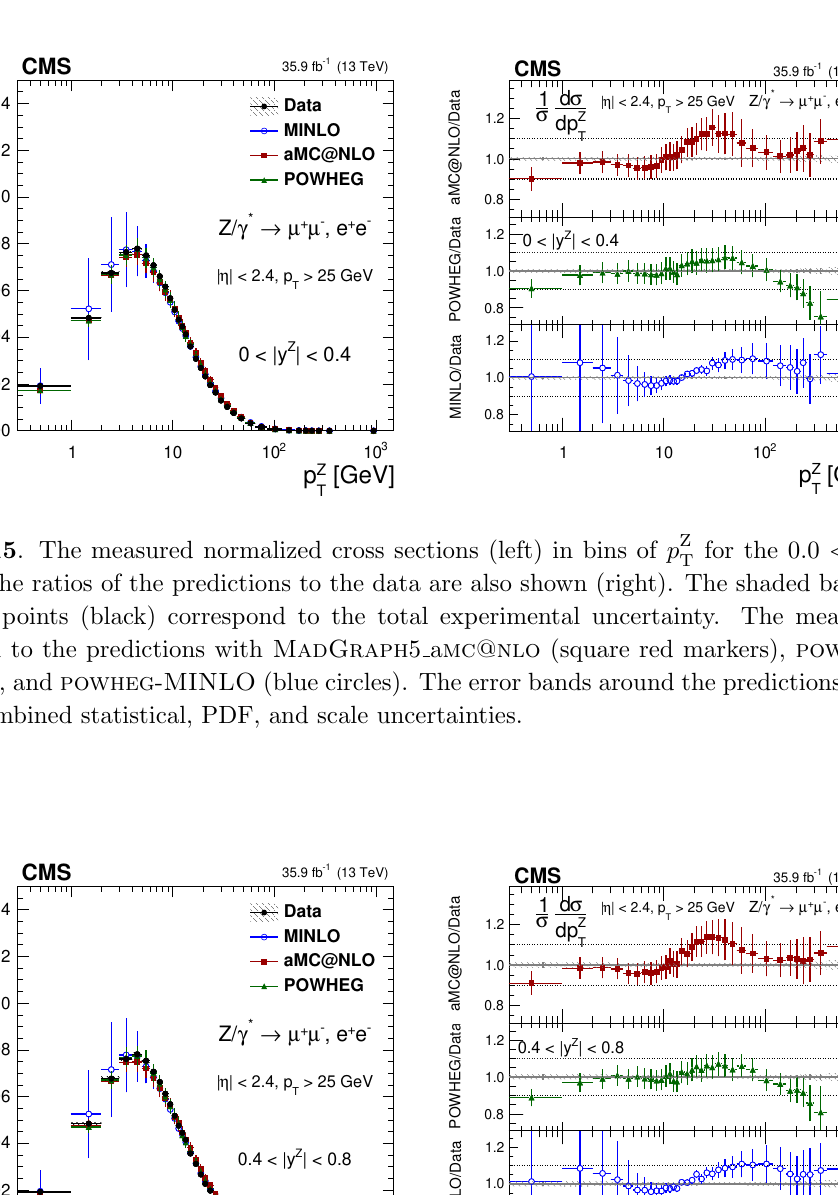
for the 0 : 4 < j y Z j < 0 : 8 T